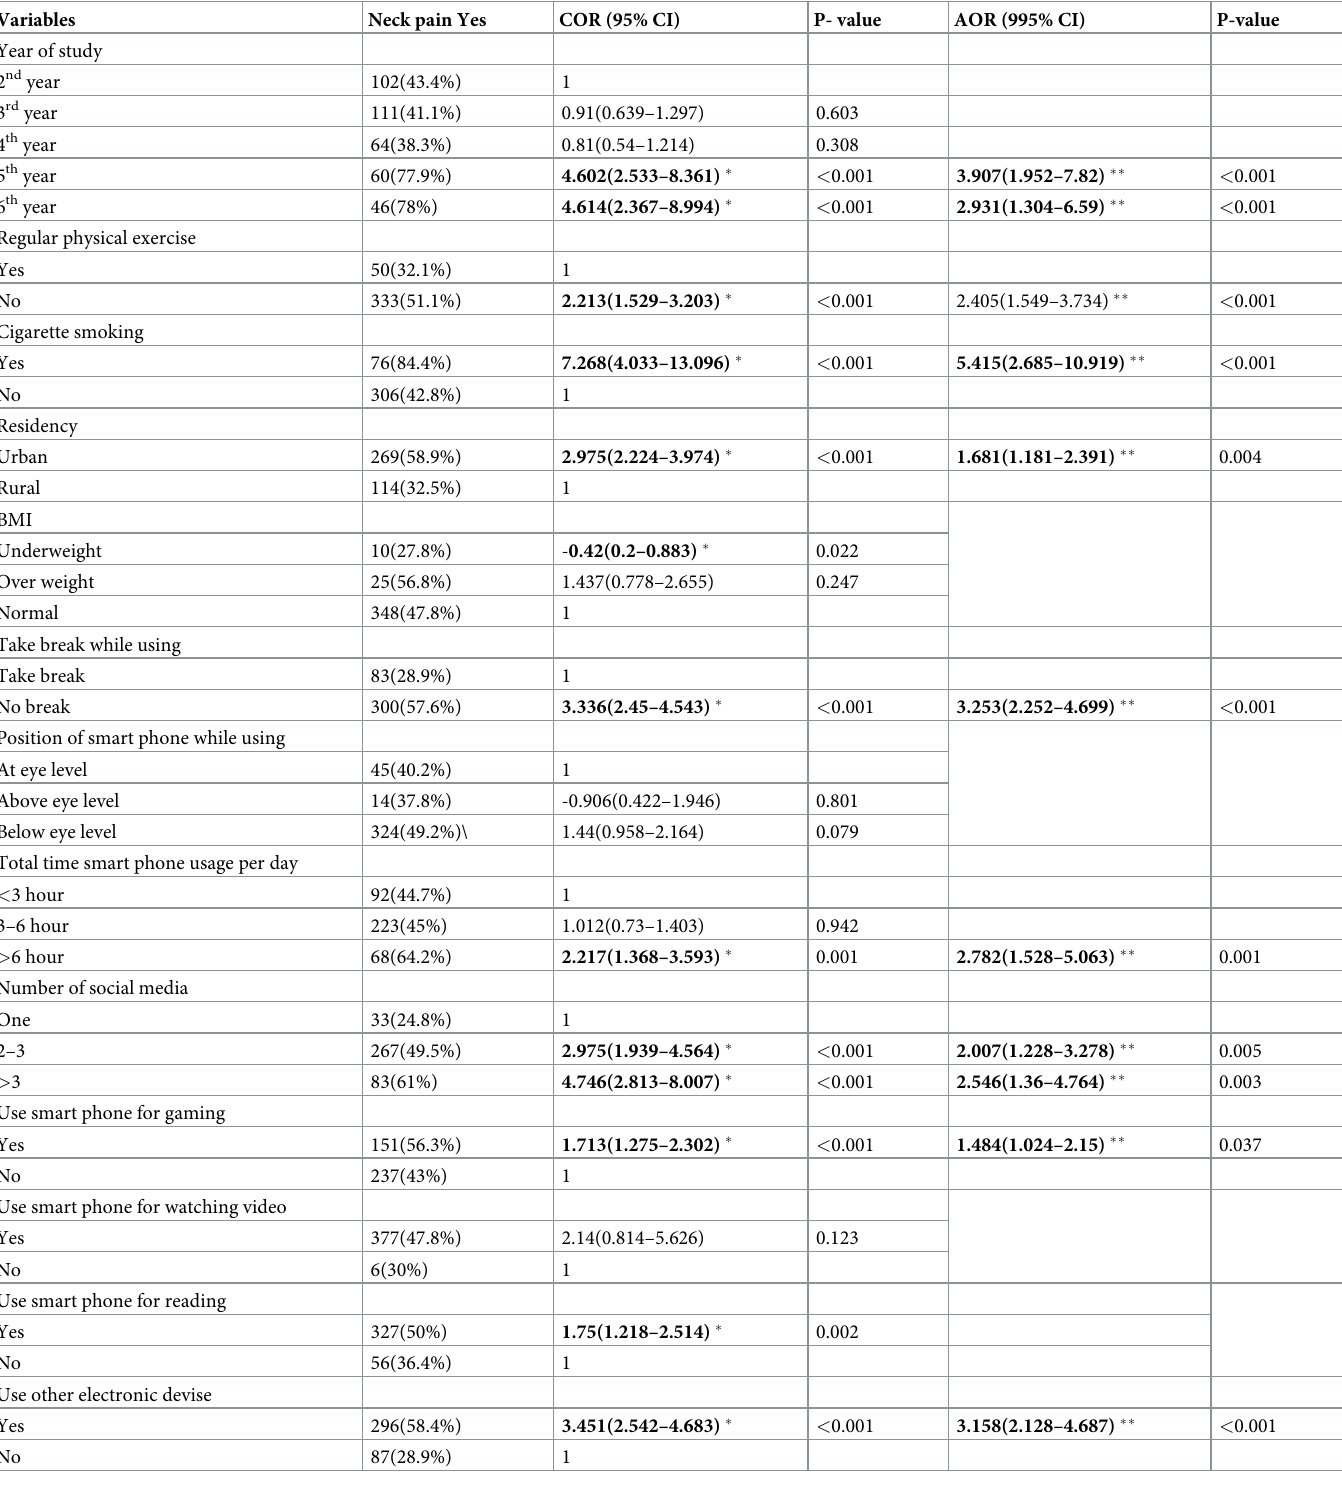
Table 3. Bivariate and multivariate logistic regression analysis of associated factors with neck pain smart phone user students, 2020. (N =